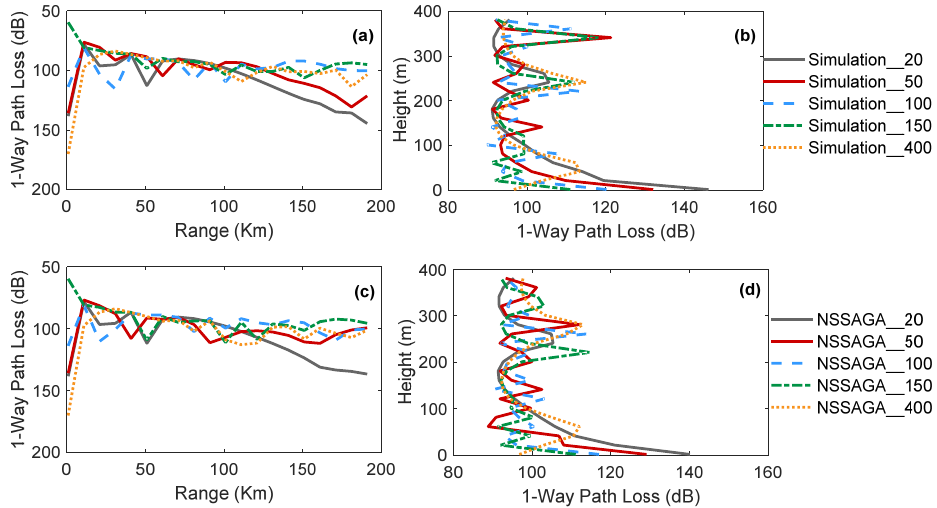
Figure 7. The propagation loss of ground-based GPS signal. ( a , c ) Simulation and inversion results at distance of 0–200 km and height of 100 m; ( b , d ) simulation and inversion results at distance of 100 km and height of 0–400 m.